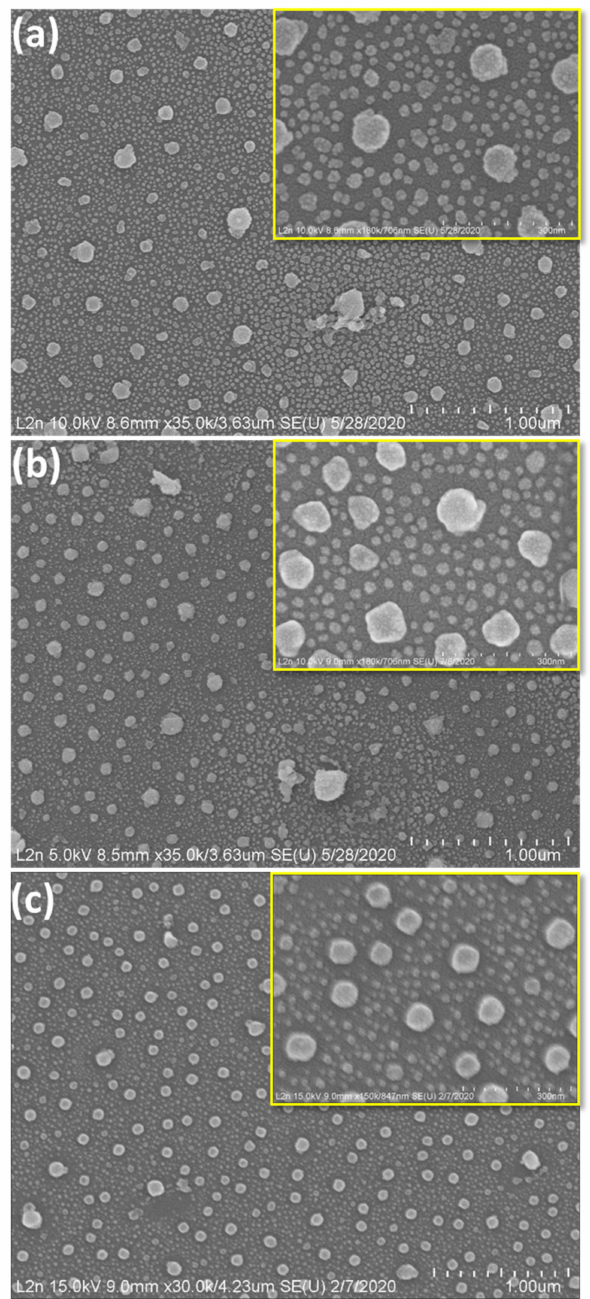
Figure 2. SEM images of 40-mM Ag/PMMA samples fabricated at different spin-coating speeds: ( a ) 3000; ( b ) 5000; and ( c ) 7000 rpm. All insets are the corresponding magnified SEM images at 300